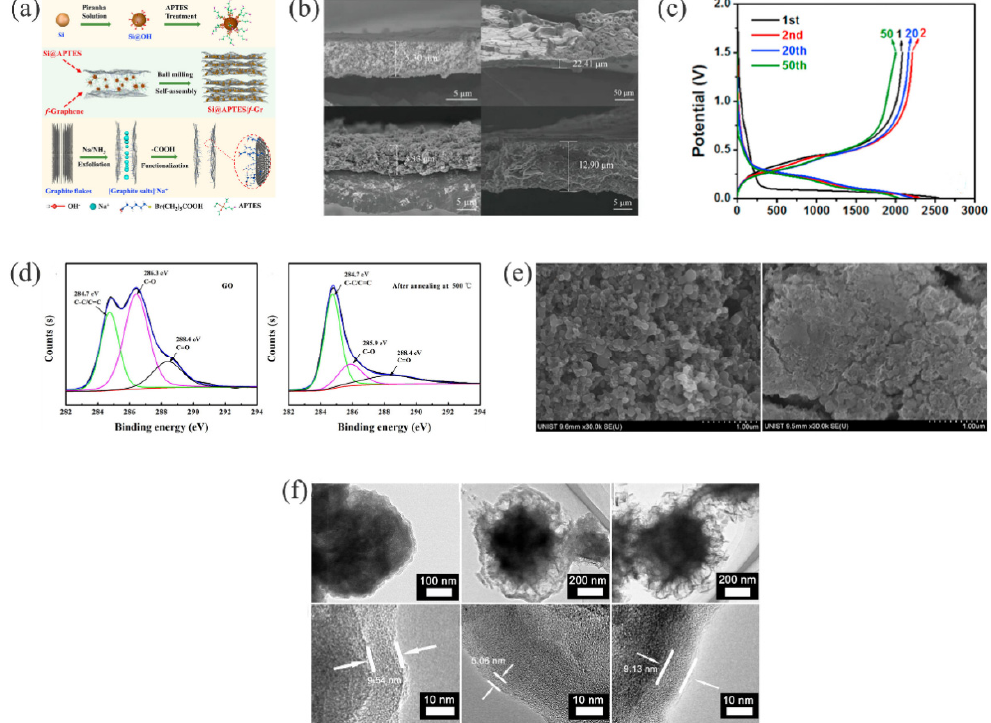
Figure 4. ( a ) Schematic diagram of the synthesis of Si@APTES/f − Gr composite [92]. Reprinted with